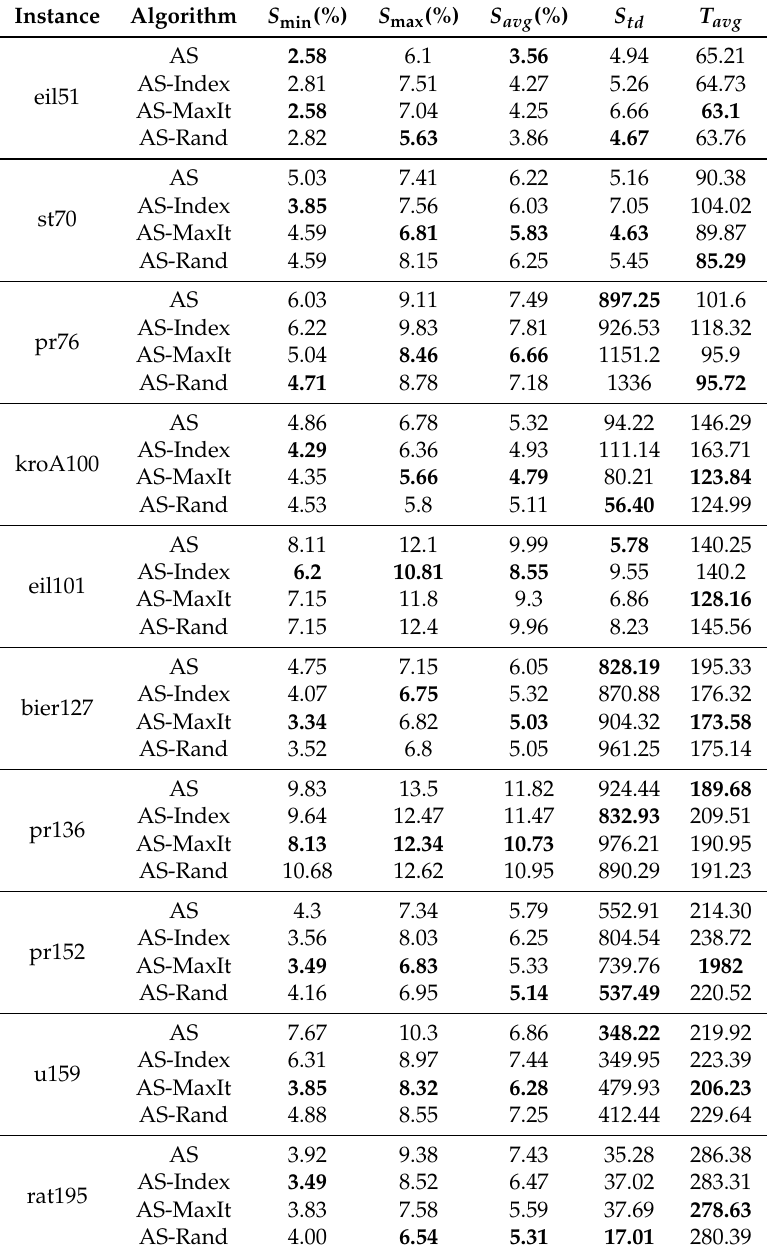
Table 1. Results comparison for small-scale example